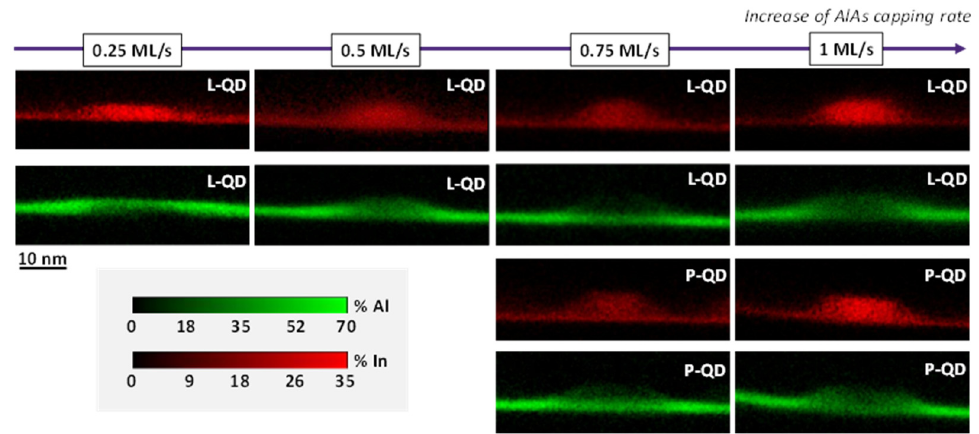
Figure 6. In (red) and Al (green) EDX maps of representative lens-shaped QDs (the top two rows) for the QD layers with CL of AlAs. We have also included examples of truncated pyramidal-shaped QDs (the bottom two rows) when the proportion of pyramids is significant (CL0.75 and CL1 layers).